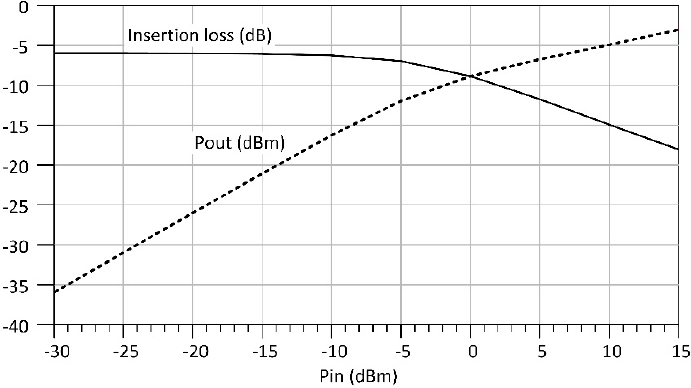
Figure 8. Simulated compression of the filter tuned at 1800 MHz.